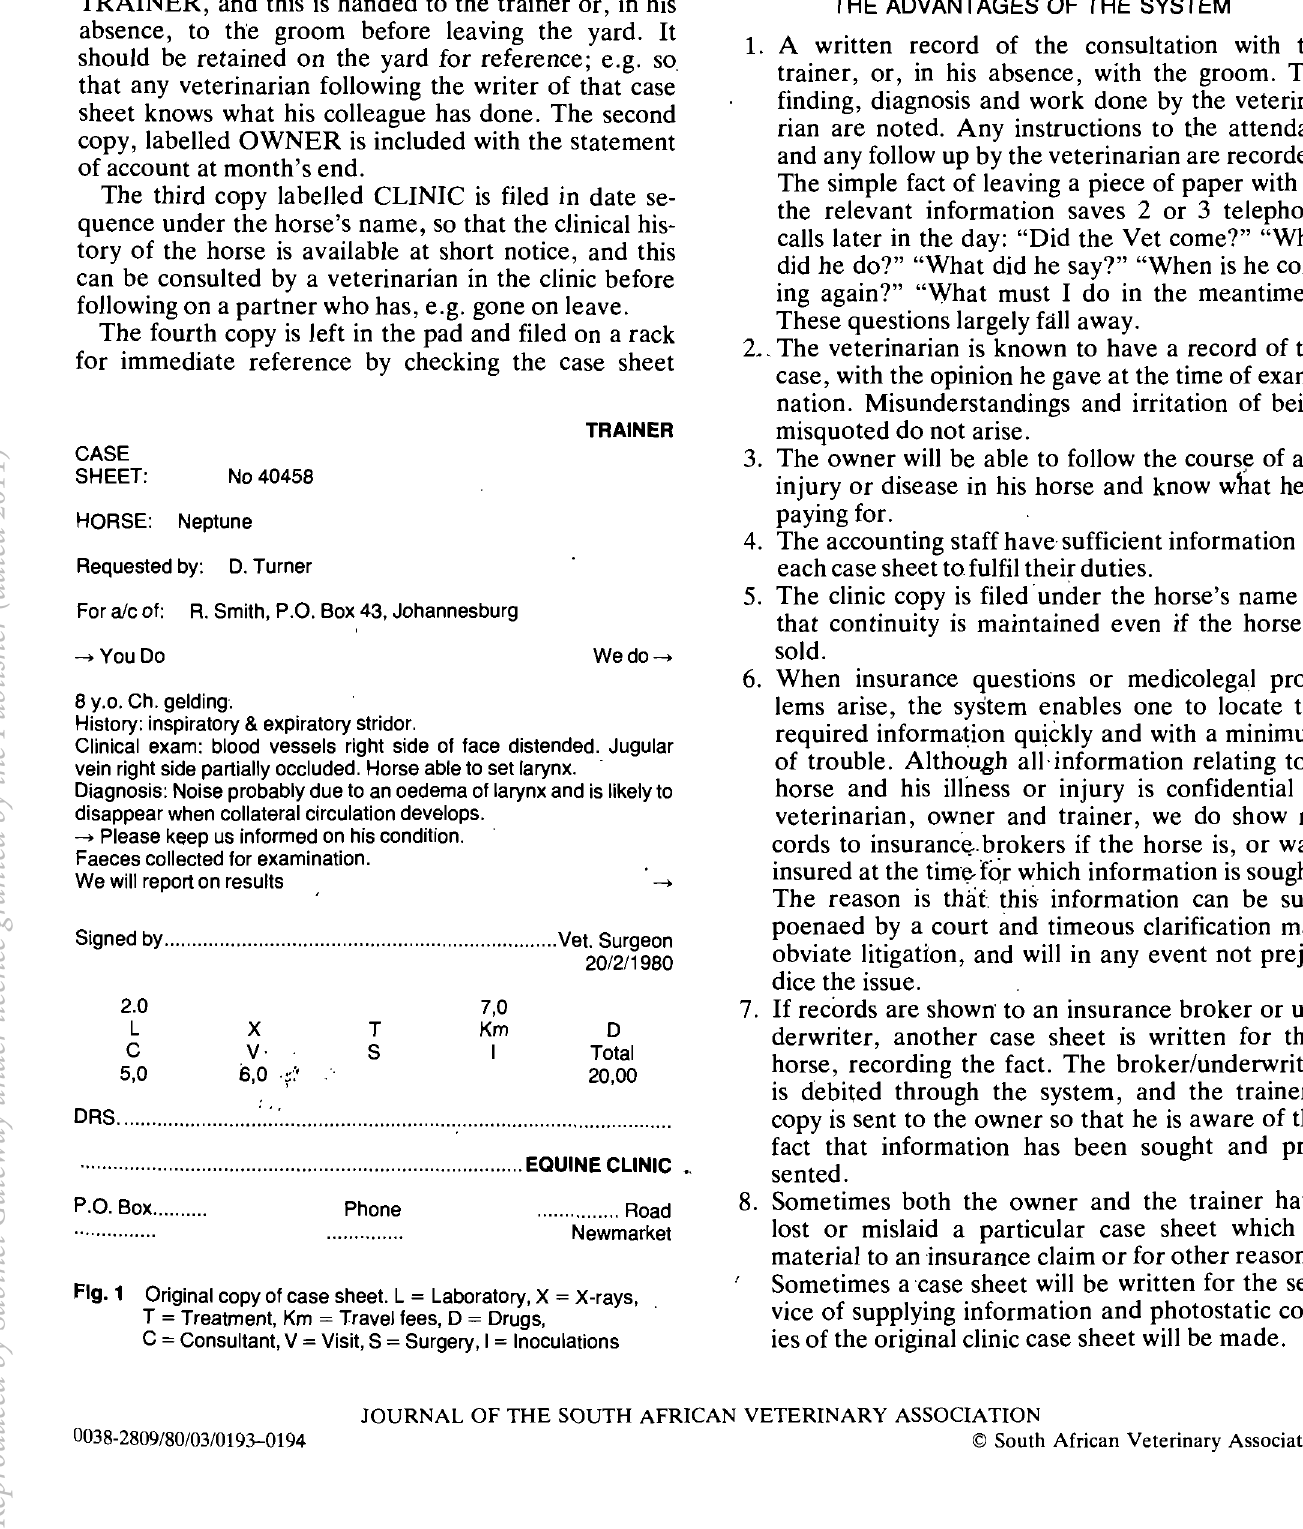
Fig. 1 Original copy of case sheet. L = Laboratory, X = X-rays, T = Treatment, Km = Travel fees, D = Drugs, C = Consultant, V = Visit, S = Surgery, I =